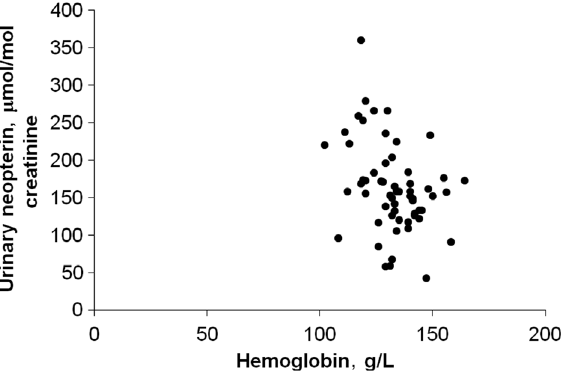
Figure 1 Correlation between hemoglobin and urinary neop- terin concentrations in patients with a history of breast cancer = –0.360, p = (r s